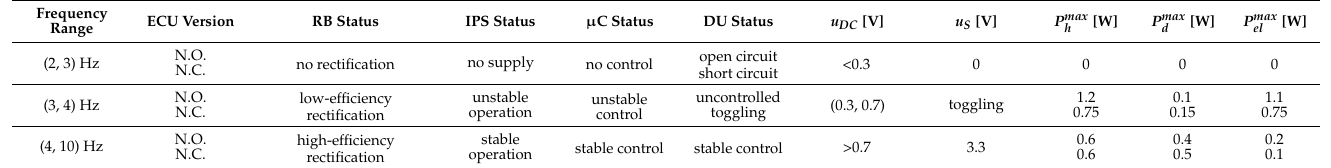
Table 3. Status of ECU blocks and maximum values of powers P h , P d , P el